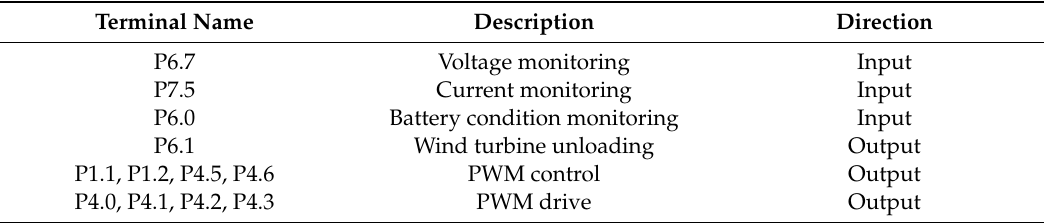
Table 8. Terminal names and general descriptions of the electrical interface of the control system.